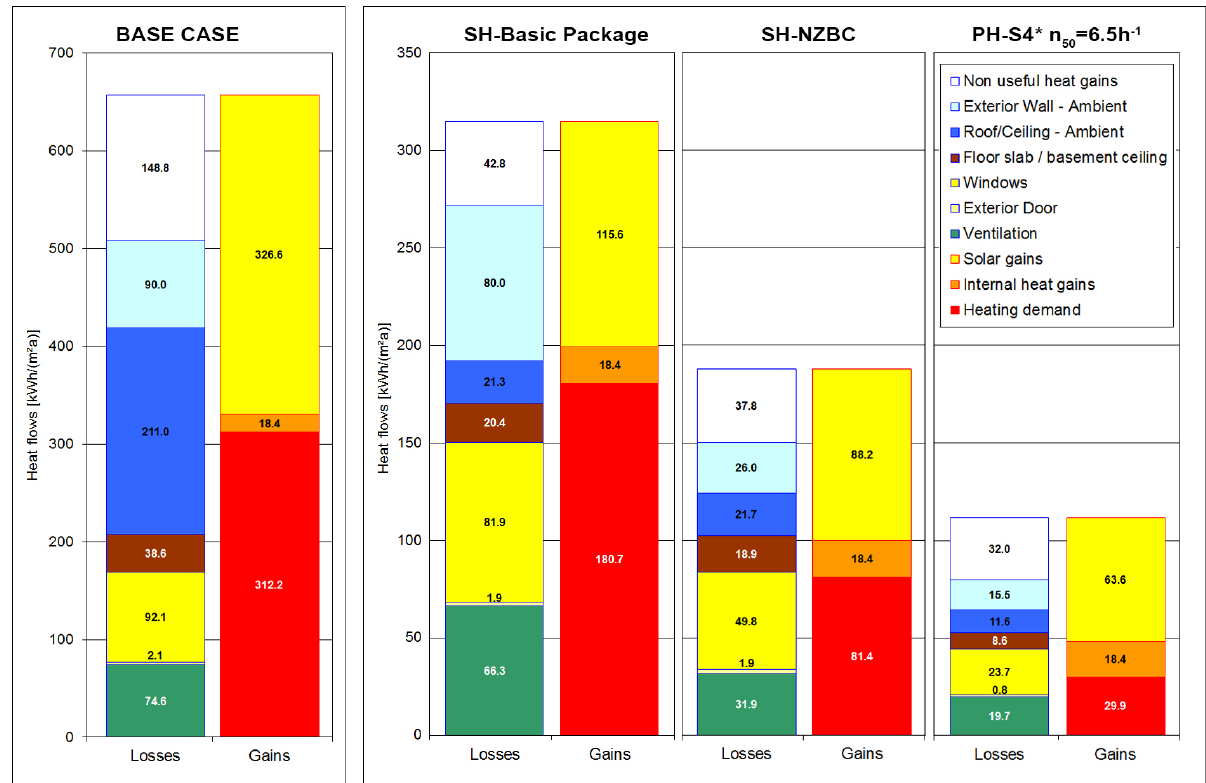
Figure 7. Heat flows (losses and gains) of the Base Case (axis maximum value: 700 kWh/(m 2 a)) and comparison of heat flows (losses and gains) of SH-BP, SH-NZBC and PH-S4* (axis maximum value: 350 kWh/(m 2 a)) calculated with